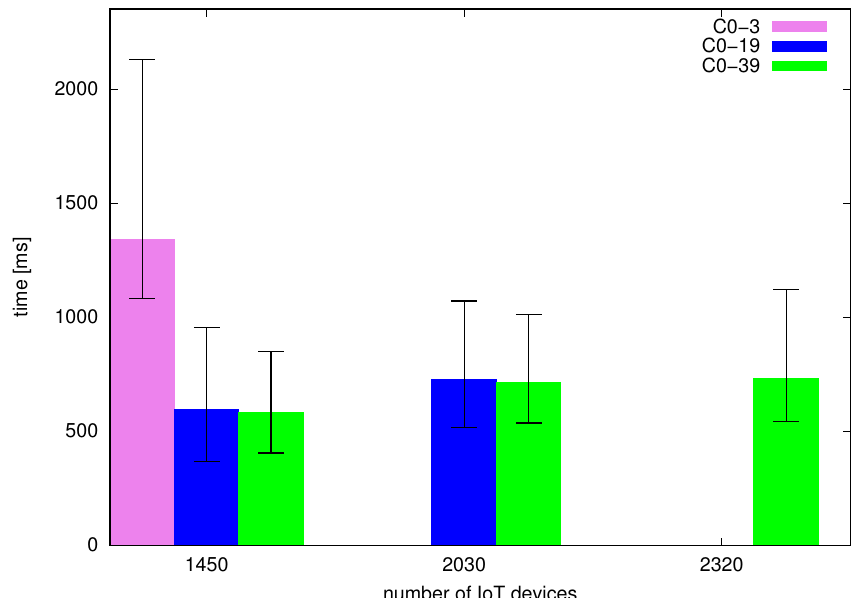
Figure 4. Processing time of request-response process from client side—bare-metal, bars denote medians and whiskers Q1 and Q3